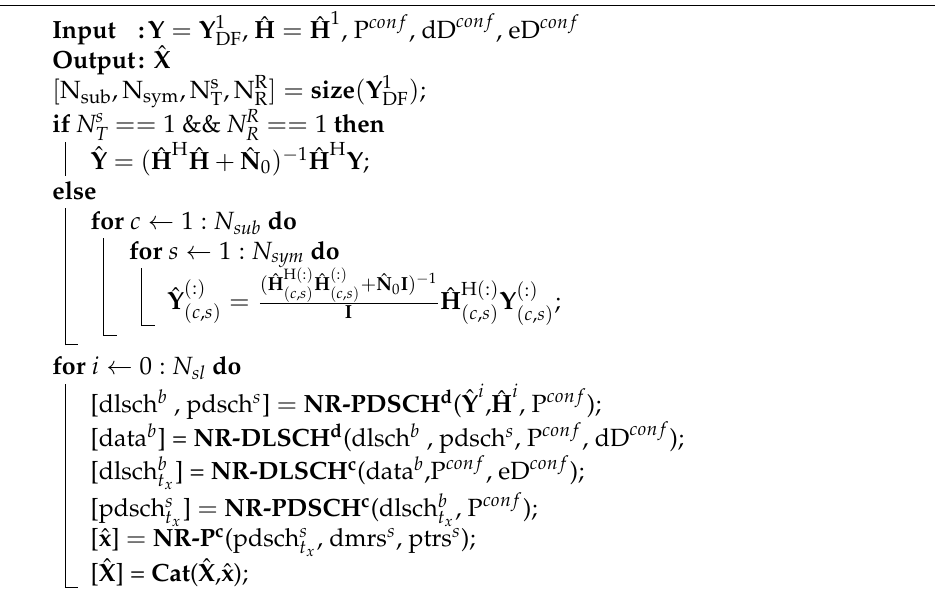
Algorithm 1: Decoding-and-Encoding New Radio RN